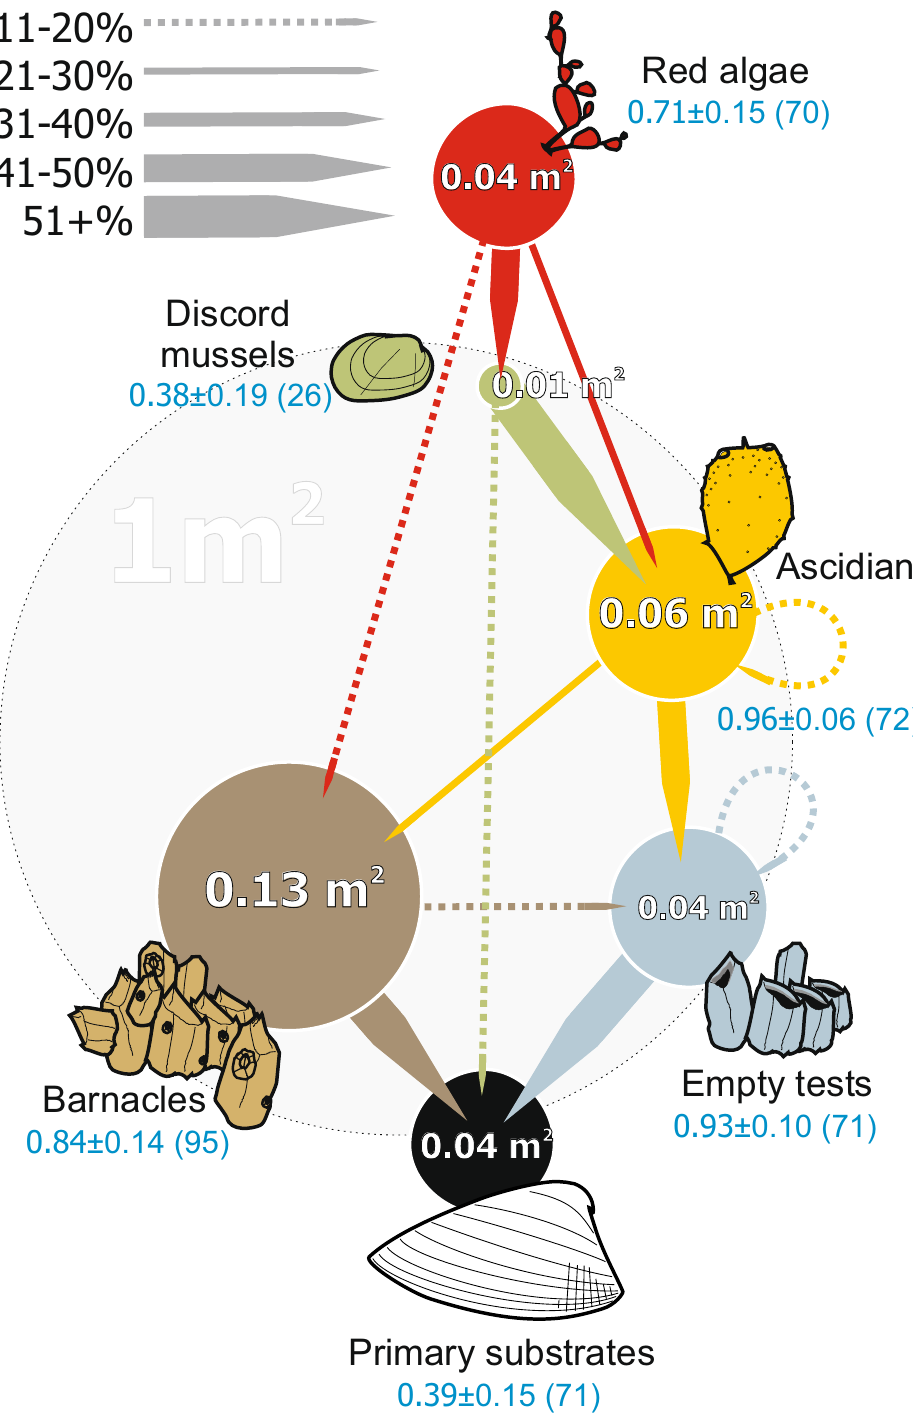
Figure 1. Substrate surface area provision and utilisation by foundation species (FS) in the field. Primary substrates: mollusk shells and pebbles, chiefly empty Serripes groenlandicus shells. Barnacles: Balanus spp., chiefly B . crenatus . Empty tests: chiefly left by B . crenatus . Ascidians: solitary ascidians Molgula spp., Styela spp., Dendrodoa grossularia , Halocynthia pyriformis . Discord mussels: Musculus discors and their nests. Red algae: Phycodrys rubens, Euthora cristata, Odonthalia dentata, Cocottilus truncatus, Ptilota gunneri, Fimbrifolium dichotomum, Polysiphonia stricta . Circle areas denote the mean approximate substrate area (m 2 ) provided by the corresponding FS to other sessile species per m 2 of the bottom. Arrow widths denote the mean fraction of this area provided by individuals that occupy the underlying substrate the arrow points to. Blue numbers: Shannon log-e diversity of the depended species associated with the FS ± S.E. In parentheses: the total number of sessile species found on the FS. All the mean values are averaged for the 3 sites, within-site variation pooled, except the arrow widths for discord mussels based on the average for sites 1 and 3 (no by-substrate measurements available for the Site 2). A grey 1 m 2 circle denotes the